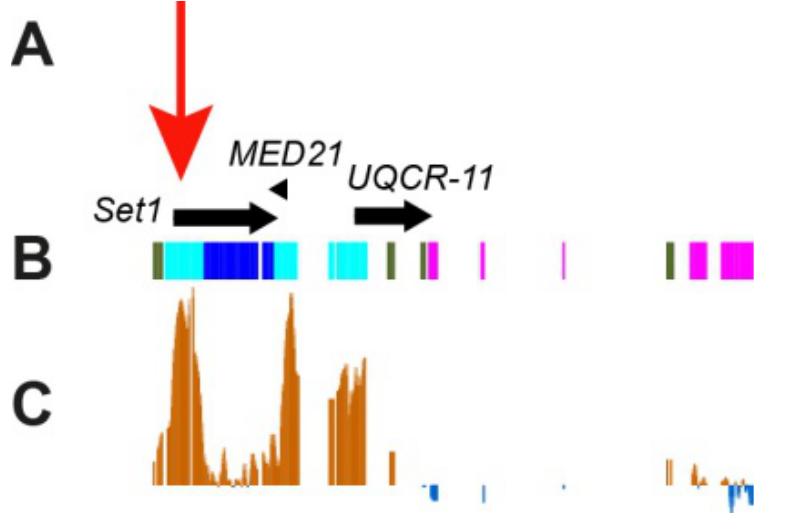
Figure 6. Locations of the housekeeping genes Set1 , and two neighboring genes, MED21 and UQCR-1 , in 3LHet. ( A ) Gene names and the direction of gene transcription (arrows). Aquamarine fragments contain housekeeping gene promoters and Lazurite fragments contain housekeeping gene bodies [6]. Red arrow ( A ) points to the position of the FISH probe; ( B ) chromatin states ac- cording to 4HMM [6]; ( C ) localization of the CHRIZ protein in the chromosomes of the S2 cell cul- ture (modENCODE).